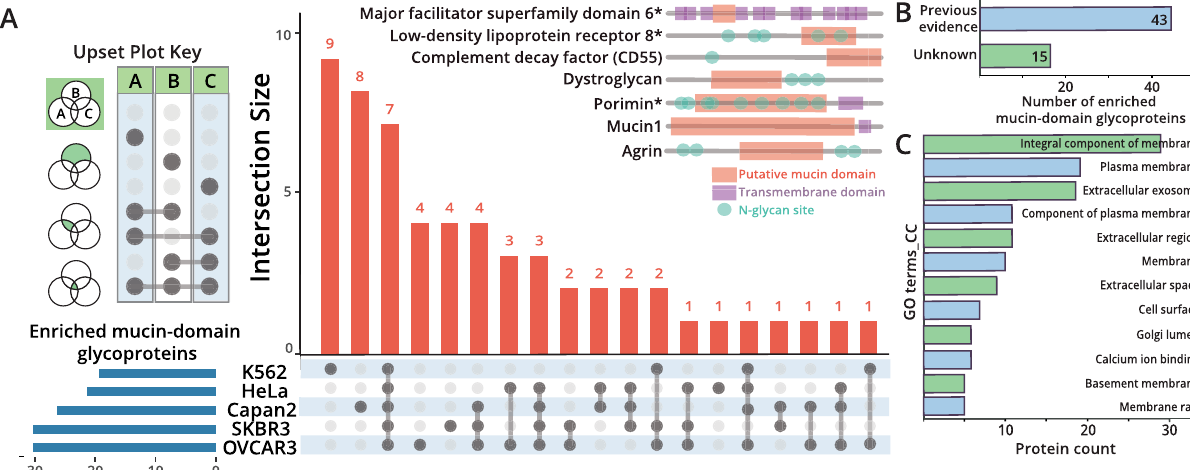
Fig. 4 Analysis of mucin-domain glycoproteins from cell line enrichments. A Upset plot comparing enriched mucin lists from fi ve cell lines. The total number of enriched mucin-domain glycoproteins from each cell line is shown on the bottom left (blue horizontal bars). If a group of mucin-domain glycoproteins was only seen in one cell line, only one gray dot is darkened; the number of proteins that are only seen in that cell line are shown in bar graph form above. Overlap between samples are shown by multiple darkened gray dots and a line connecting them. A total of seven mucin-domain glycoproteins were seen in all fi ve cell lines; these proteins are shown above the Upset plot. The seven proteins found in all fi ve samples are shown above the plot; putative mucin domain (orange), transmembrane domains (purple), and N-glycan sites (green) are annotated based on Uniprot assignments (transmembrane domain, N-glycan sites) and the mucin-domain candidacy algorithm (mucin domain). B Discovery of new mucin glycoproteins. The total list of enriched mucin proteins was searched against the SimpleCell dataset 51 . If O-glycopeptides within the assigned mucin domains were found in this dataset, a protein was considered as a previously described mucin-domain glycoprotein; if not, it was considered a previously undescribed mucin-domain glycoprotein. C Mucin GO term enrichment. Enriched cellular component (CC) GO_terms using DAVID 55,56 are shown with protein count indicated on the x-axis. Source data are in Supplementary Data 4 and